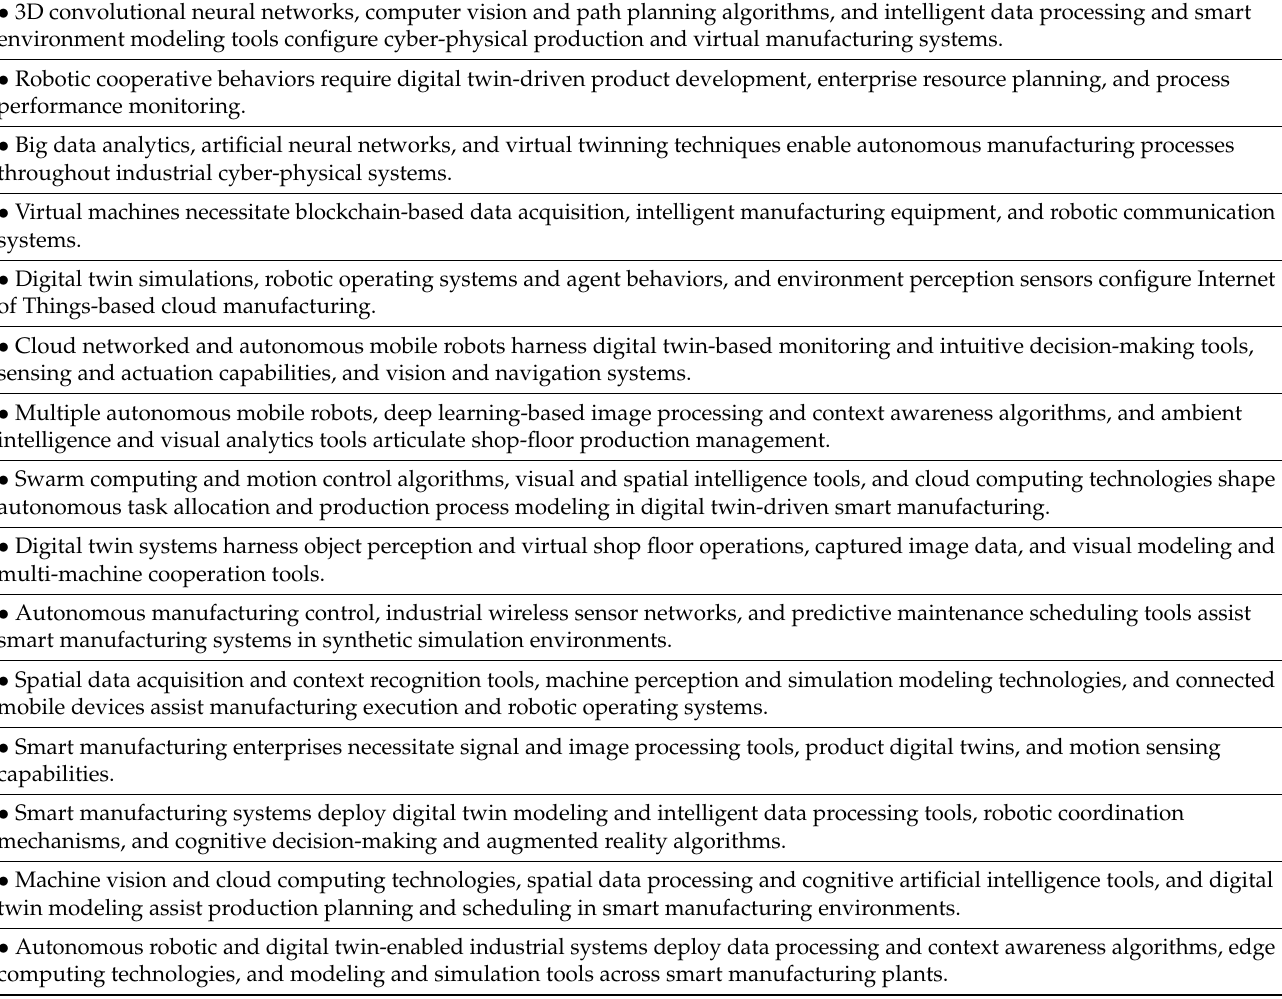
Table 1. Summarized findings related to deep learning and virtual simulation algorithms, cyber- physical production networks, and Industry 4.0-based manufacturing